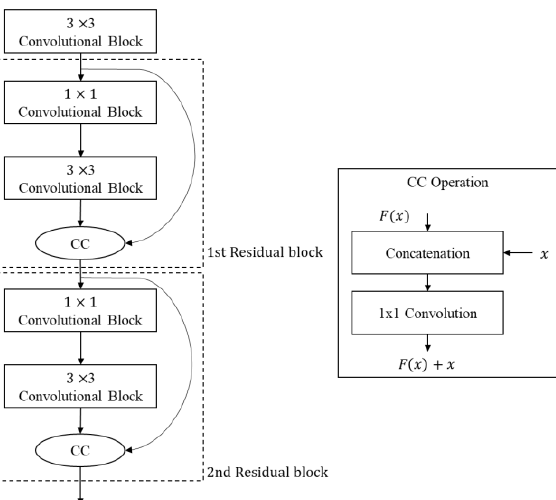
Figure 10. Concatenation–convolution. Figure 10.